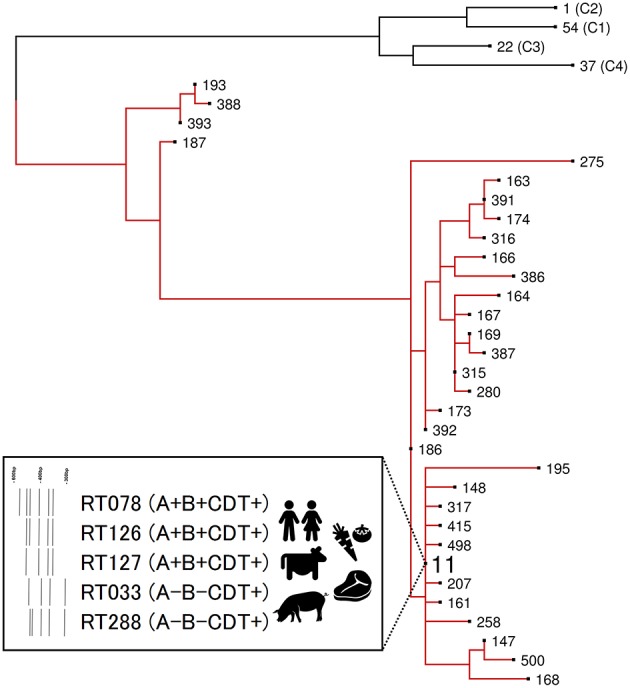
Evolutionary clade 5. Maximum-likelihood phylogeny based on concatenated MLST allele sequences (seven loci, 3,501 bp) for 32 known clade 5 STs. For global phylogenetic context, well-characterized representatives of major MLST clades C1 (ST54, RT012), C2 (ST1, RT027), C3 (ST22, RT023), and C4 (ST37, RT017) are also shown. Branches for clade 5 are shown in red. The inset box highlights major ST11 RT sublineages of clinical and agricultural/livestock importance with associated toxin gene profiles and graphical representation of 16s−23s rRNA PCR ribotyping banding patterns.